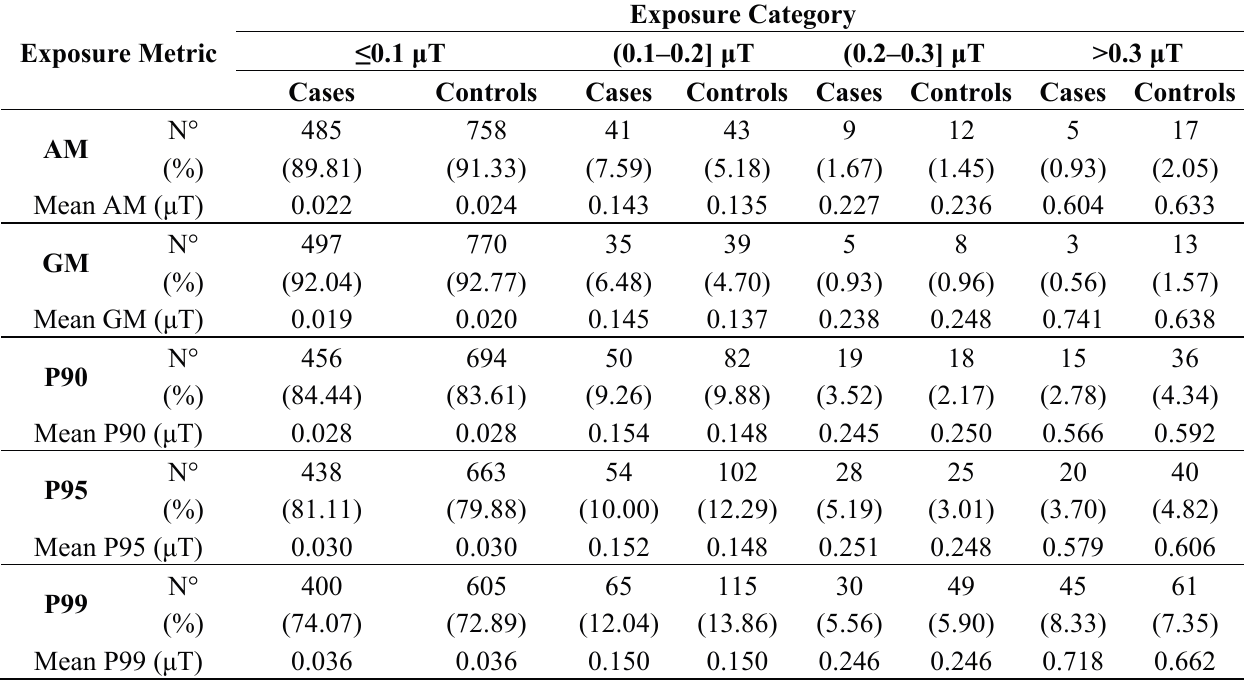
Table 3. Distribution of cases and controls with valid measurements by categories of exposure